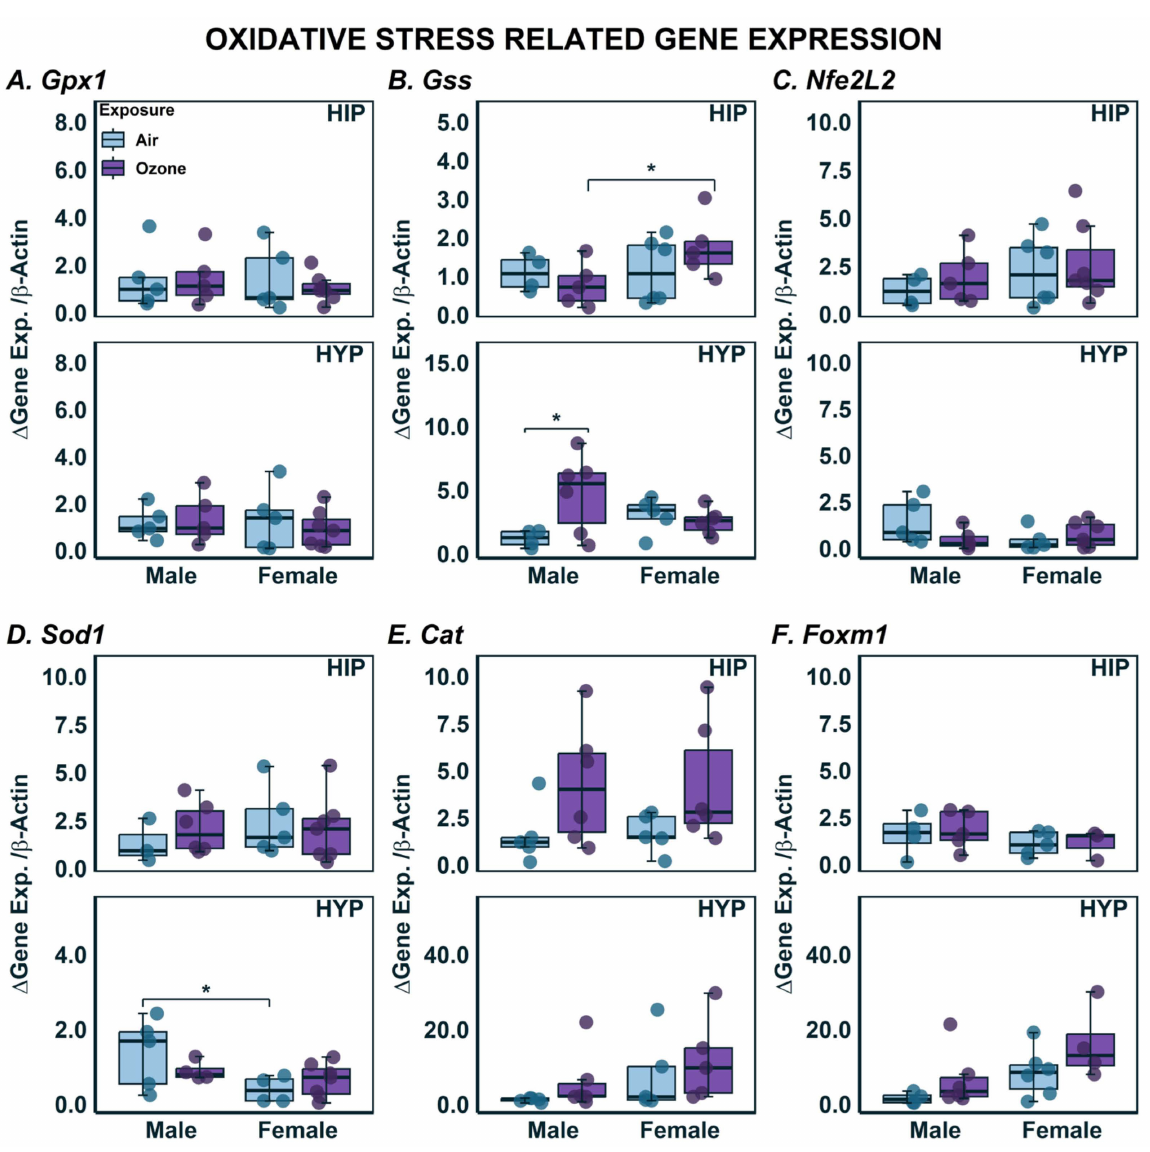
Figure 4. Gene Expression related to oxidative stress in the hippocampus (HIP) and hypothalamus (HYP) following ozone exposure in male and female rats. ( A ) Gpx1 ; ( B ) Gss ; ( C ) Nfe2l2 ; ( D ) Sod1 ; ( E ) Cat ; ( F ) Foxm1 expression was assessed using qPCR in HIP and HYP. Data are expressed